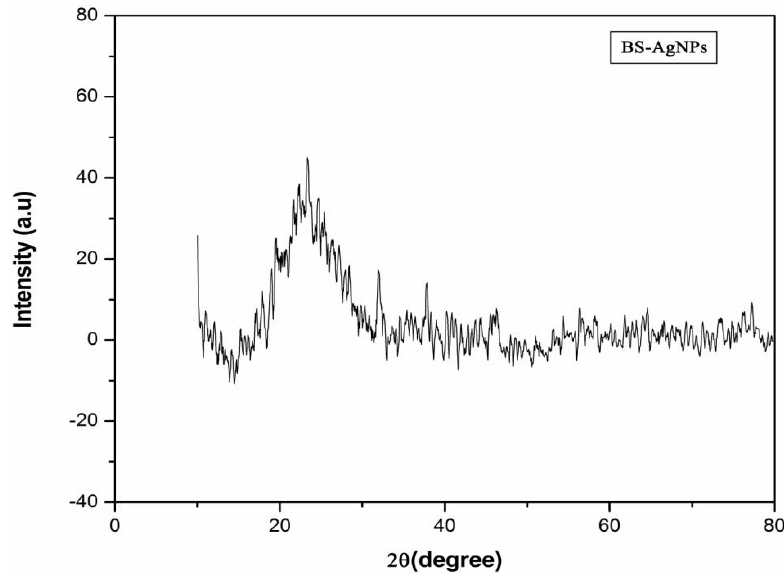
Figure 7. XRD. X-ray diffraction analysis showing the characteristic crystalline nature of the silver nanoparticles, illustrating the diffraction peaks corresponding to their intensity.